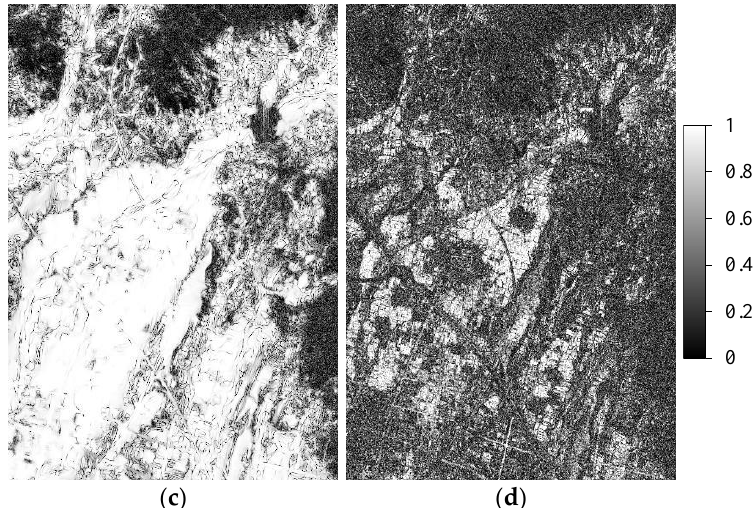
Figure 5. Interferograms of the Sentinel-1 satellite data in the Dengfeng area, China: ( a ) interferogram with temporal baseline of six days, ( b ) interferogram with temporal baseline of thirty-six days, ( c ) coherence map of the interferogram with temporal baseline of six days, ( d ) coherence map of the interferogram with temporal baseline of thirty-six days.